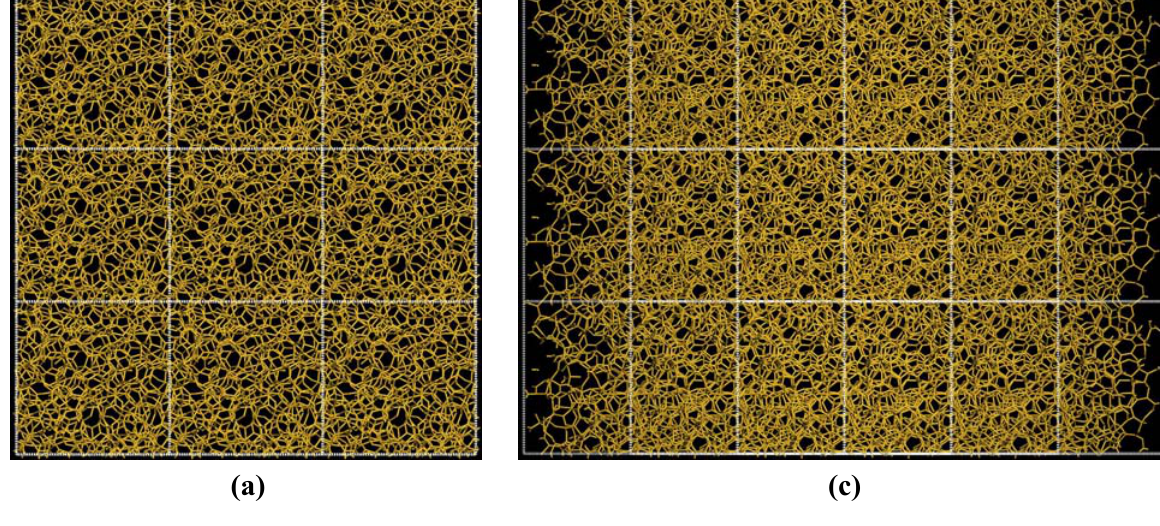
Figure 14. Structure of porous silicon for 3 × 3 × 3 supercells. Small through pores appear along the directions (a) y, (b) z, (c) xz and (d) xy. There may be dendritic